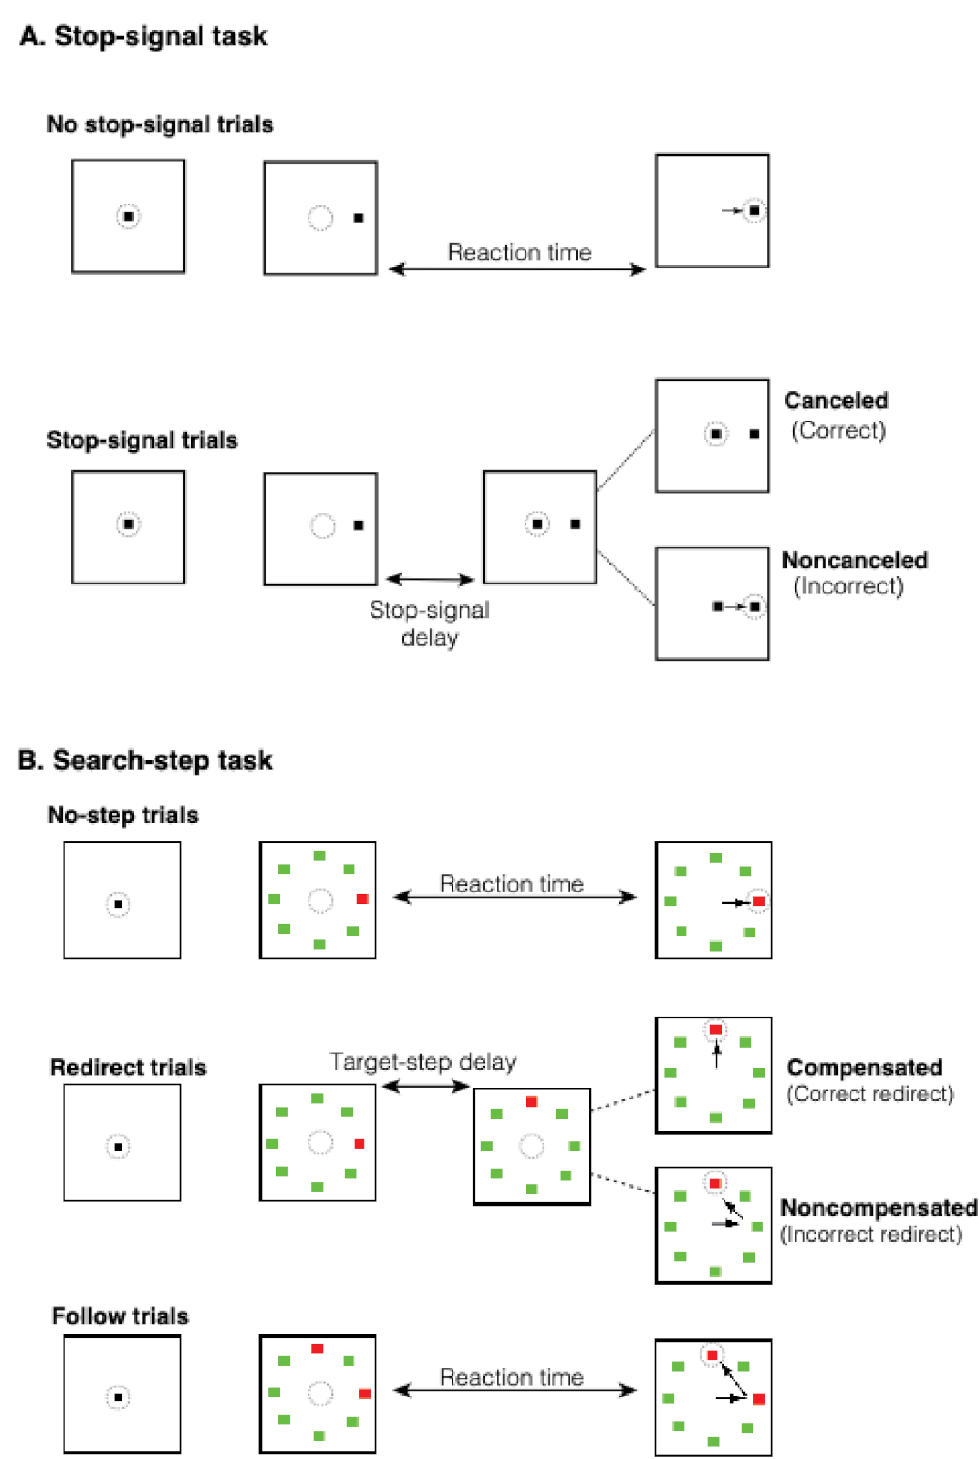
Figure 1. Experimental tasks. Dotted circles indicate gaze position and the arrow indicates the direc- tion of the saccade. ( A ) The saccadic stop-signal task. The task comprised two randomly interleaved trial types: no stop-signal and stop-signal trials. Participants began each trial by maintaining their gaze on a central fixation point. Following a variable fixation period, the fixation point disappeared and simultaneously reappeared to the left or right of the central fixation. Participants were instructed to look at the peripheral target as quickly as possible. In stop-signal trials, however, the central fixation target reappeared after a short, variable delay (stop-signal delay (SSD)). In these trials, participants were instructed to withhold the planned saccade to the peripheral target. Trials in